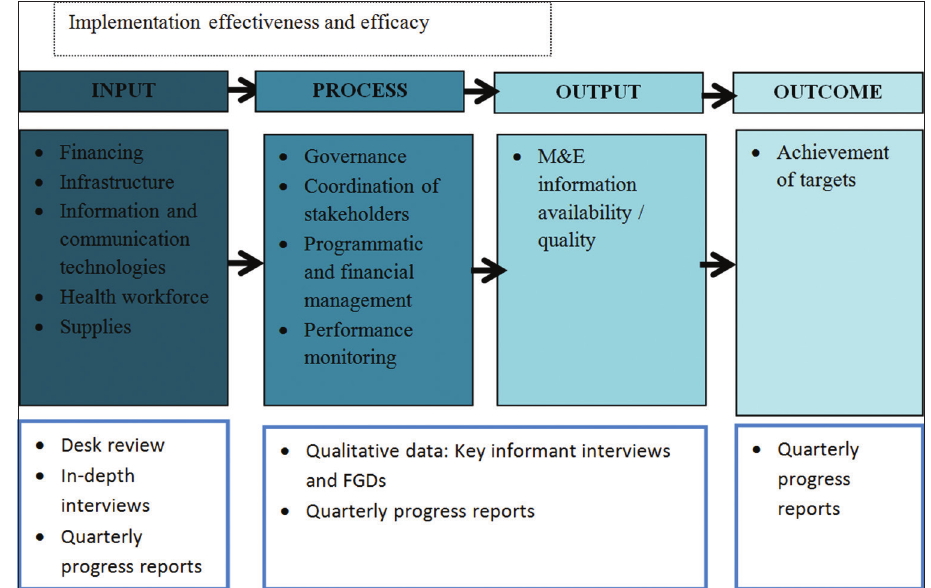
Figure 4 : Assessment framework for NCS Study in Rwanda Source: Adapted from WHO HSS building blocks